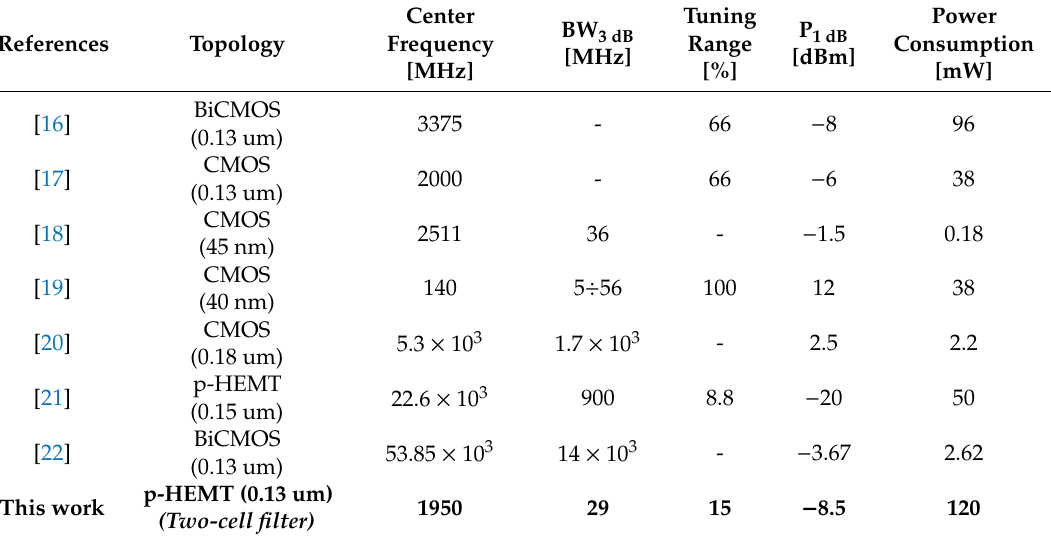
Table 2. Comparison with di ff erent literary